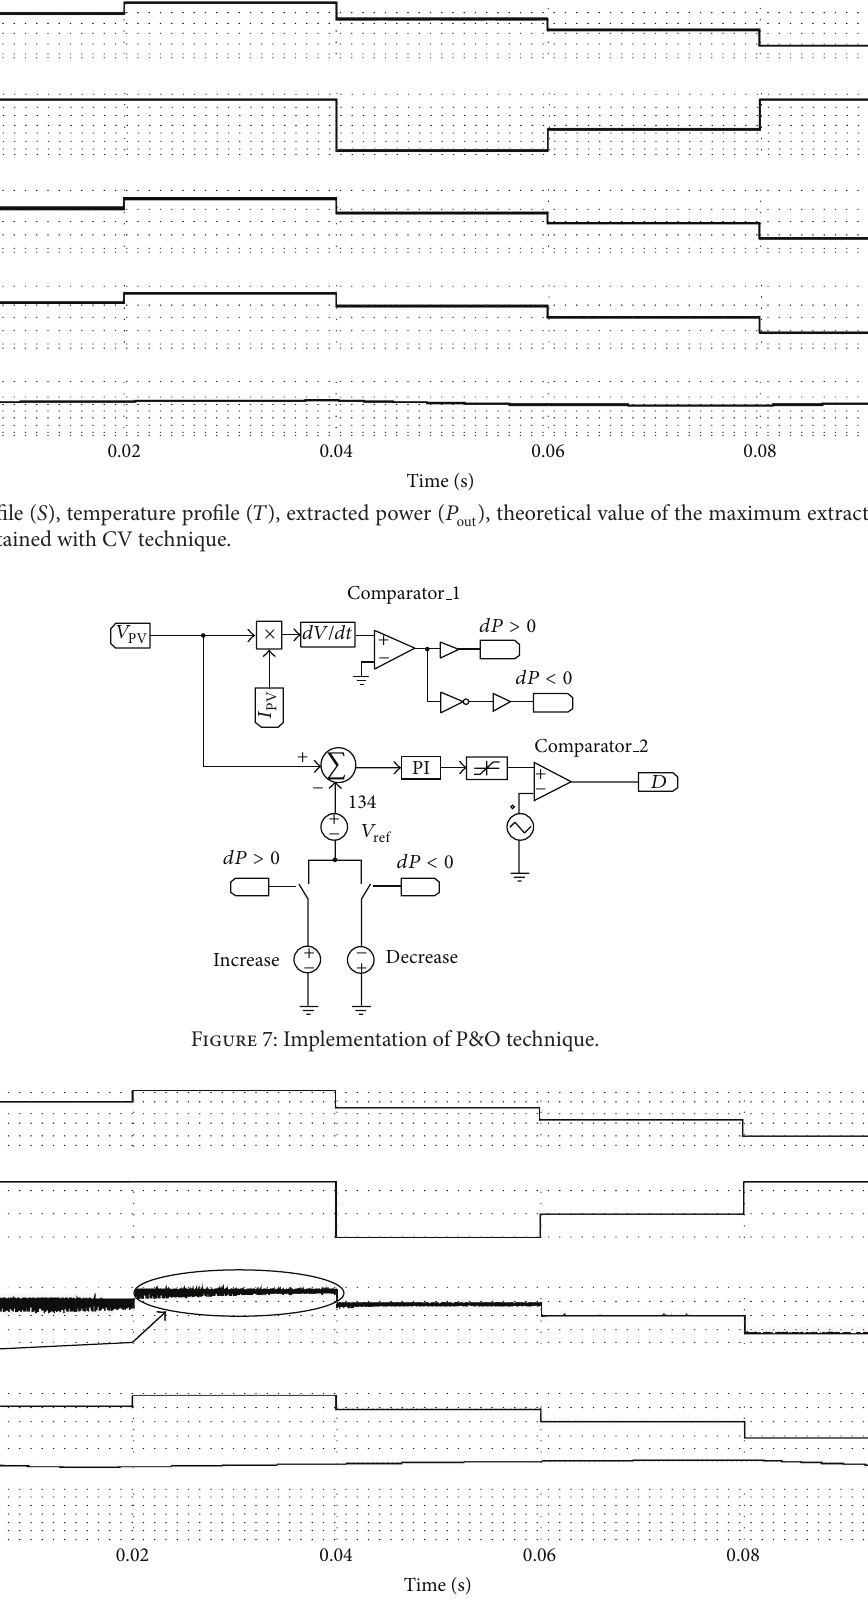
), theoretical value of the maximum extracted power ( 𝑃 max ), out